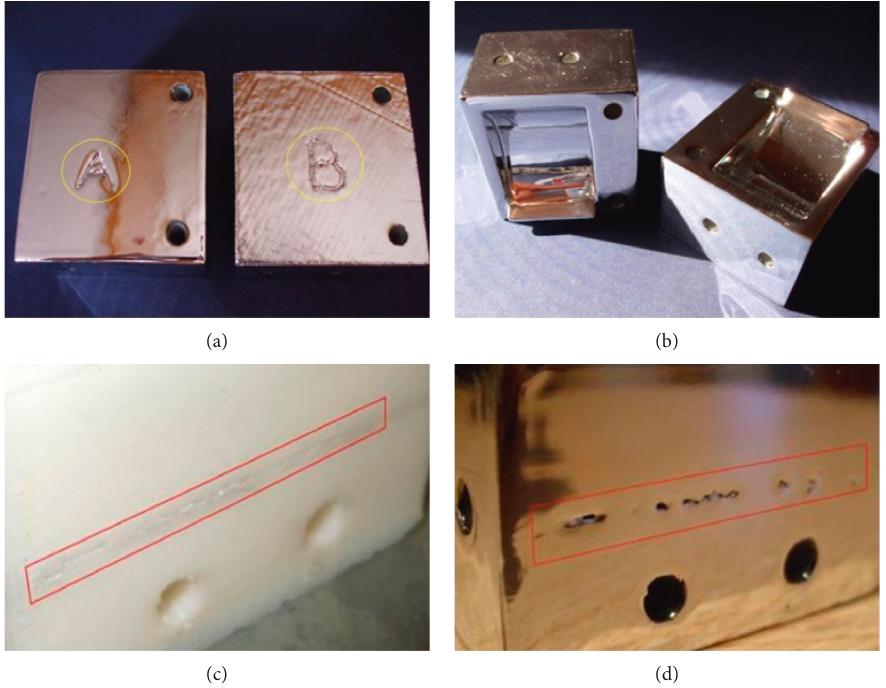
Figure 5: PVD test pieces and superficial defects on the test pieces.